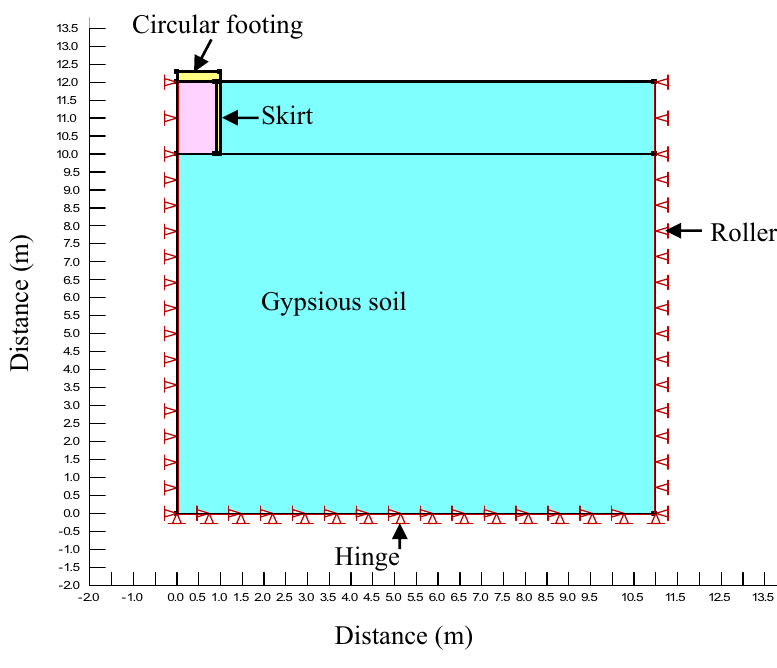
Figure 5: Rollers and hinges boundary conditions assigned of circular skirted footing